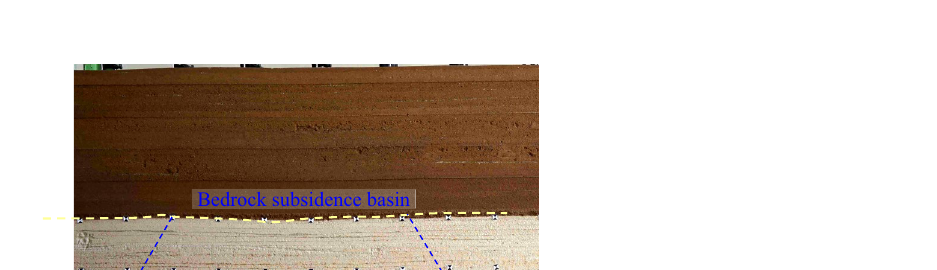
Figure 3. Strata subsidence in BPZ.